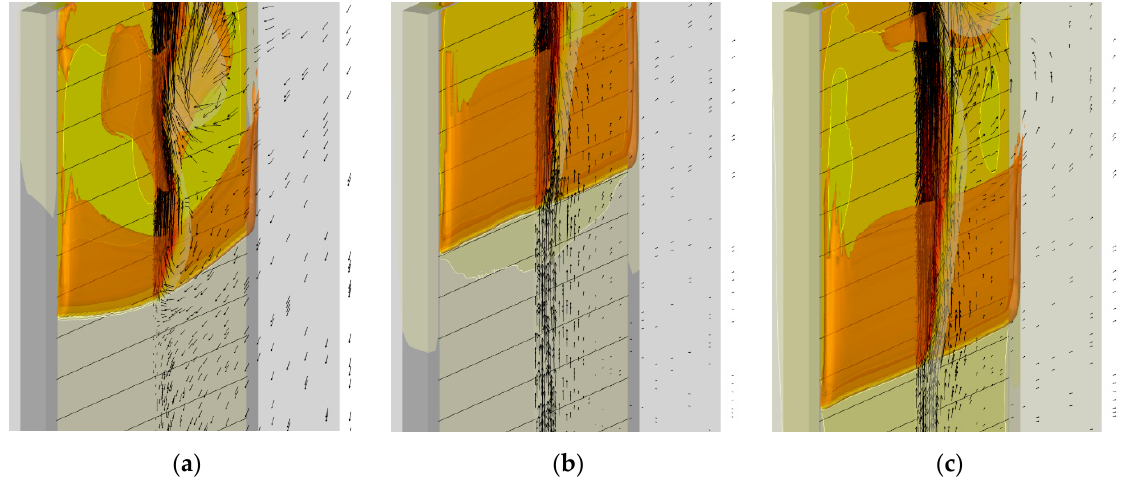
Figure 22. Predicted flow field near the flame front at time instant of 60 s. The same distributions are shown as those in Figure 20 jointly with the gas velocity vectors in the vertical symmetry plane.